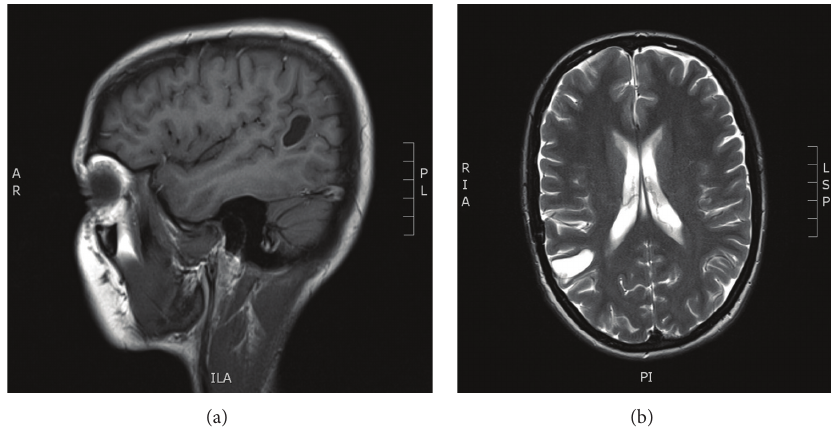
Figure 1: CT scan showing a hemangioblastoma in the right temporal lobe in the noncontrast and contrast series.